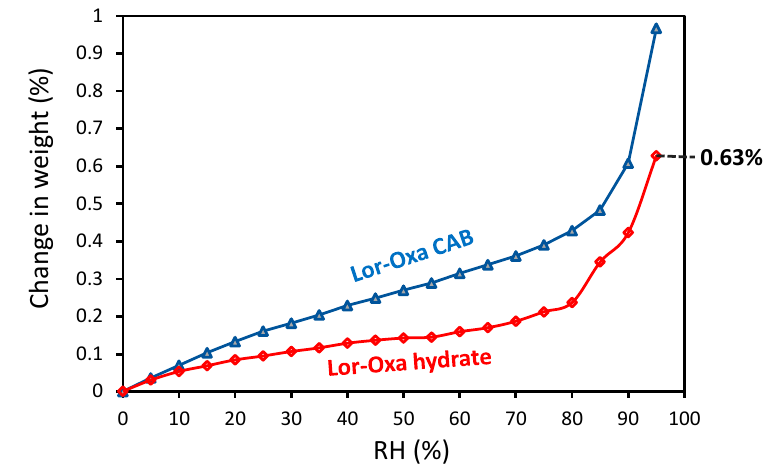
Figure 7. Moisture sorption isotherms of Lor-Oxa CAB and Lor-Oxa hydrate.